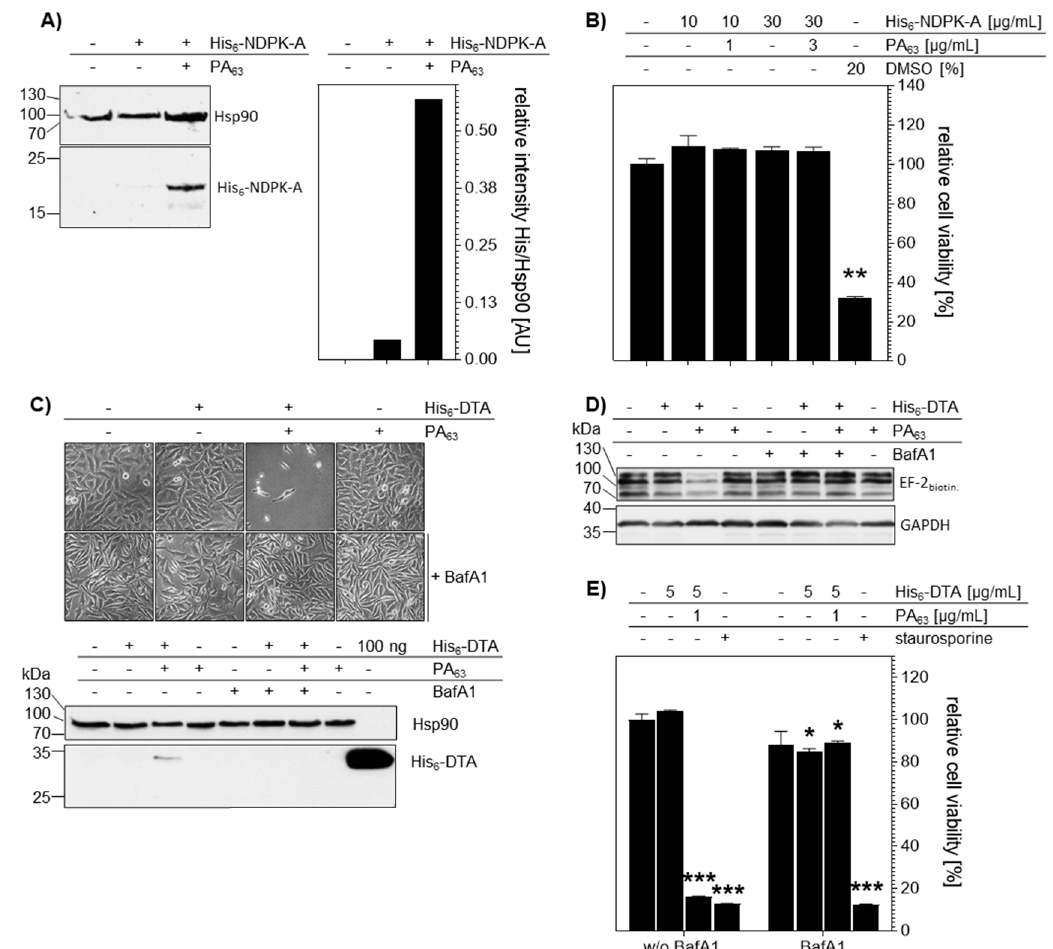
Figure 6. PA 63 mediates delivery of His 6 -NDPK-A and His 6 -DTA into HeLa cells. ( A ) PA 63 delivers His 6 -NDPK-A into HeLa cells in a PA 63 -dependent manner. After incubation of the cells with His 6 -NDPK-A (10 µ g / mL) and PA 63 (1 µ g / mL) or His 6 -NDPK-A only for 6 h at 37 ◦ C, the cells were analyzed by immunoblotting. The uptake of His 6 -NDPK-A was detected with an anti-His-antibody. Hsp90 was detected as loading control and densitometric analysis performed using the ImageJ software. Signal intensity of His 6 -NDPK-A was quantified against Hsp90. ( B ) Cell viability is not reduced by treatment of cells with His 6 -NDPK-A plus PA 63 . After incubation of the cells with His 6 -NDPK-A plus PA 63 or His 6 -NDPK-A alone for 48 h at 37 ◦ C, the cell viability was determined by the MTS assay. Data were normalized to untreated cells (control). DMSO served as positive control. Data are given as mean ± SD, n = 3. ( C ) Uptake of His 6 -DTA is mediated by PA 63 and is sensitive to BafA1. Cells were incubated with BafA1 (30 nM) for 30 min at 37 ◦ C followed by 24 h incubation with His 6 -DTA (5 µ g / mL) with or without PA 63 (1 µ g / mL). Representative pictures are shown. Thereafter, cell lysates were analyzed by immunoblotting for the presence of His 6 -DTA with an anti-His-antibody. Detection of Hsp90 was used as loading control. ( D ) PA 63 mediates delivery of His 6 -DTA into the cytosol of HeLa cells. Substrate modification was determined via strep-POD after sequential ADP-ribosylation of EF-2 as described. To confirm comparable protein loading, GAPDH was again used as loading control. ( E ) Cell viability is decreased after treatment of cells with His 6 -DTA plus PA 63 . Cells were incubated with His 6 -DTA alone or in combination with PA 63 for 24 h at 37 ◦ C. Cell viability was determined by the MTS assay. Staurosporine (1 µ M) served as positive control. Data are given as mean ± SD, n = 3. Significance was tested using One-Way ANOVA followed by Dunnett’s multiple comparison test. * p ≤ 0.05, ** p ≤ 0.01, *** p ≤ 0.001 vs. untreated control.